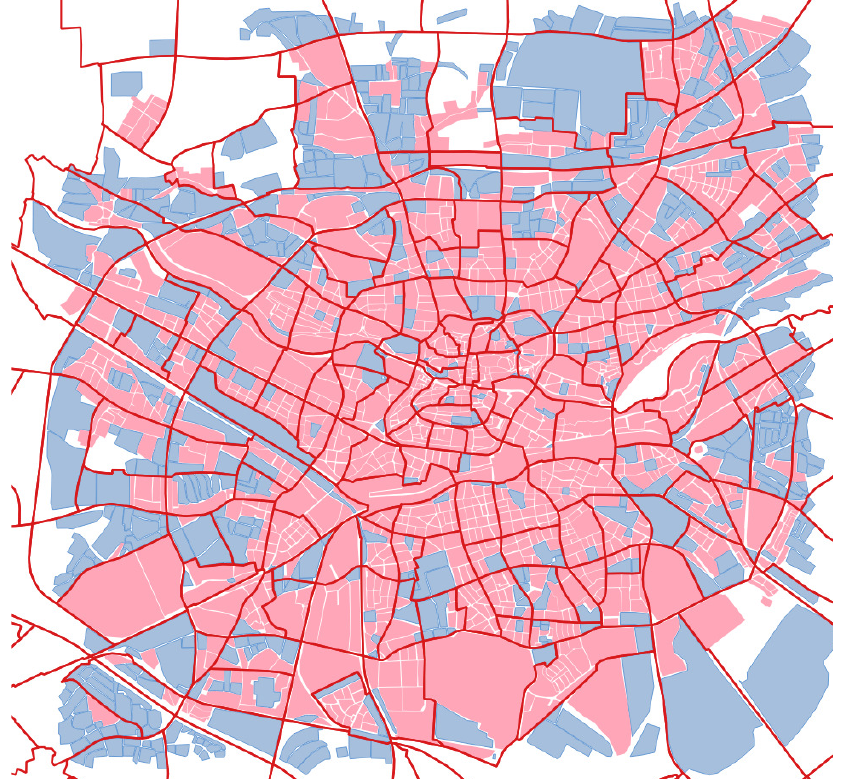
Figure 9. Blocks with consistent pre‐war and modern typology (in pink) and with altered typology (in blue) with district boundaries (in red) for the central area of Nuremberg.